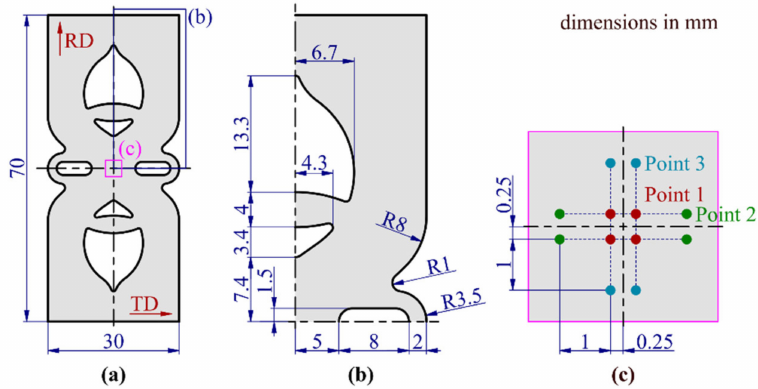
Figure 2. The geometry of the purposely developed heterogeneous test for use on a standard uniaxial testing machine: ( a ) shape with overall dimensions, ( b ) detailed section, ( c ) location of twelve strain acquisition points at the centre of the